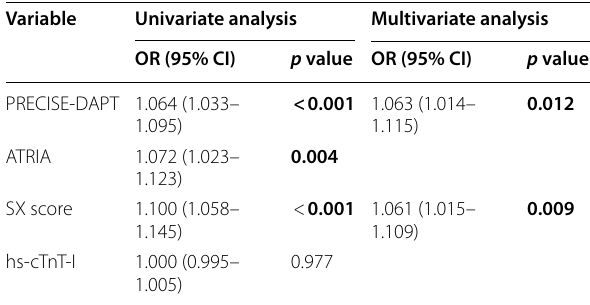
Table 2 Univariate and multivariate analysis of in-hospital